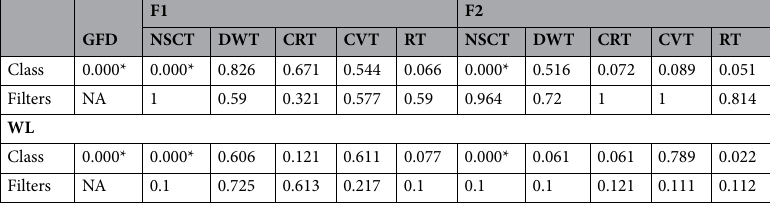
Table 1. Summary of statistical significance of feature vectors. *Less than ‘5% level of